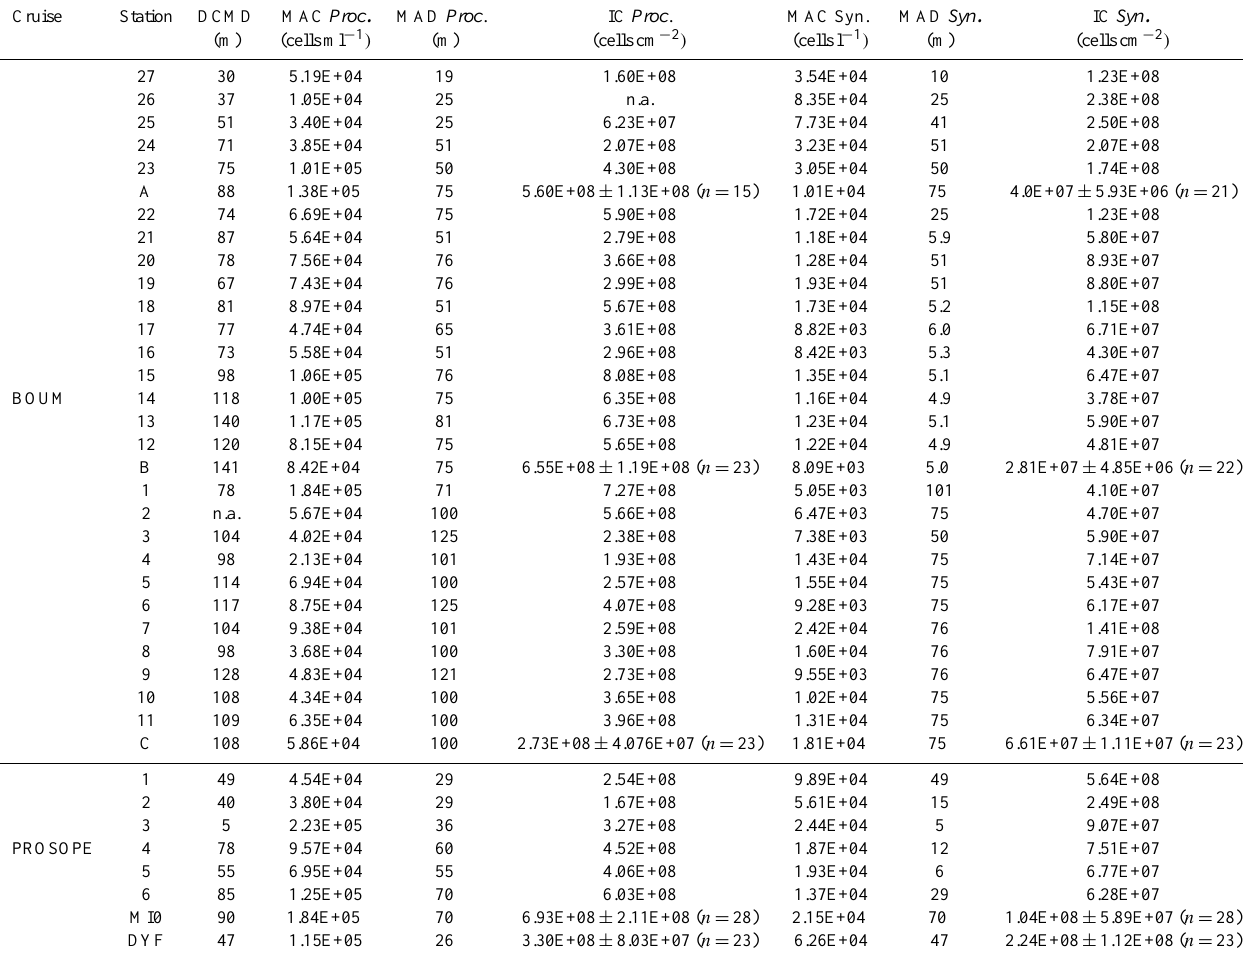
Cruise Station DCMD MAC Proc. MAD Proc . IC Proc . MAC Syn. MAD